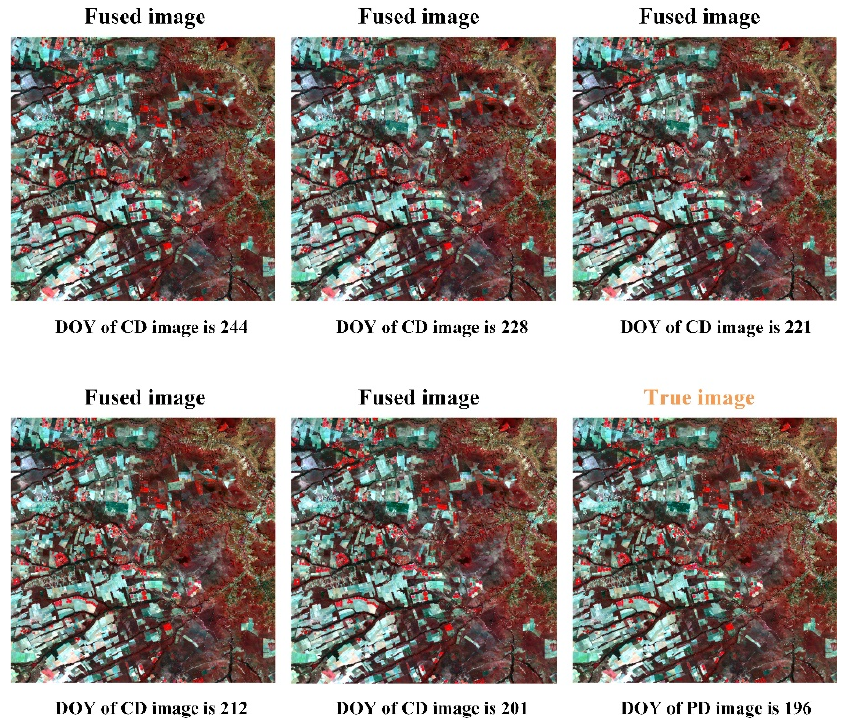
Figure 7. Standard false-color-composite images of the fused images with different CDs for the MLC period and the true image.